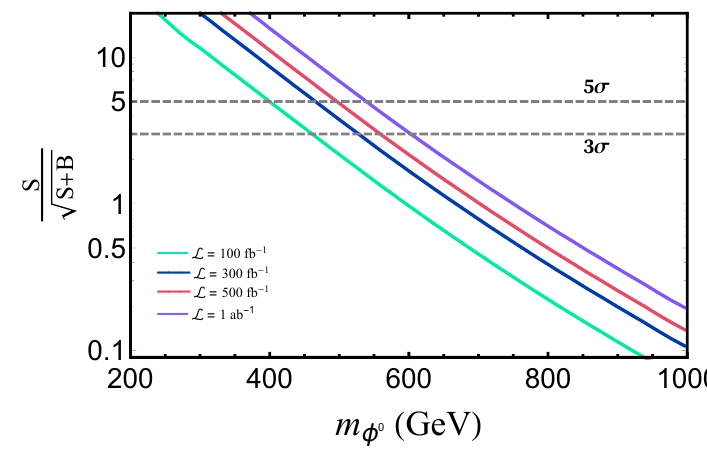
Figure 12 . Signi(cid:12)cance of the signal pp ! l + l (cid:0) (cid:28) + (cid:28) (cid:0) in SU(2) H model at 14 TeV LHC with integrated luminosity L = 100 ; 300 ; 500 and 1000 fb (cid:0) 1 .